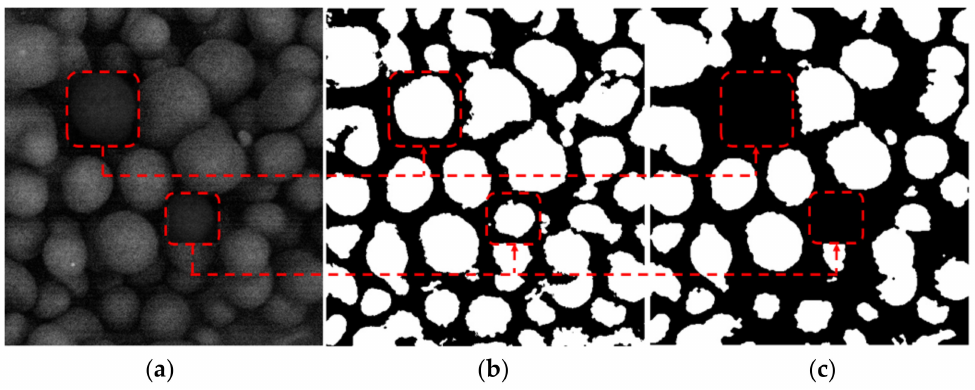
Figure 3. Binary segmentation. ( a ) Inhomogeneous grayscale images. ( b ) Adaptive threshold segmentation results. ( c ) Ostu segmentation